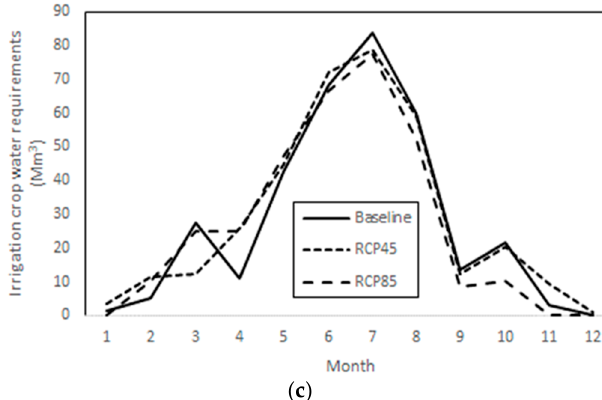
Figure 3. Sardinia fast-track Water-Energy-Food Nexus simulation for 2010 (baseline) and 2030 under RCP4.5 and 8.5: ( a ) the total aggregated water stored in all Sardinian reservoirs; ( b ) energy generation and consumption, where generation matches consumption in each month, and; ( c ) irrigation crop water